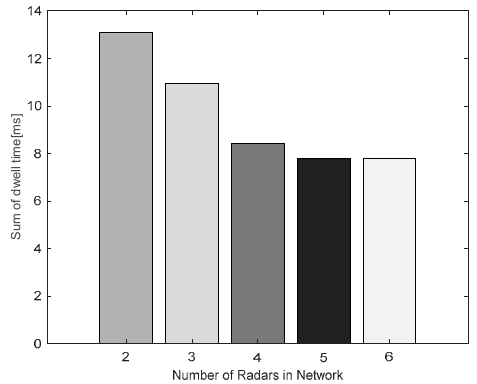
Figure 13. Comparison of total dwell time of radar network with different numbers of radars.